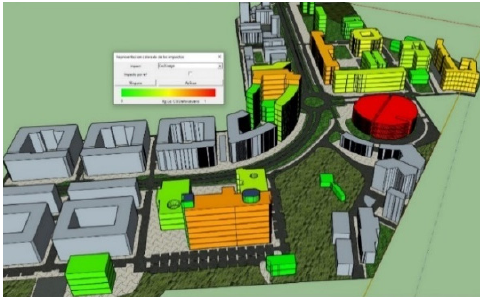
Figure 21. NEST model with simulation of CO 2 impacts. UPV/EHU DSS campus. Table 7. Results obtained in the NEST simulation of the improvement scenarios for the years 2030 and 2050.